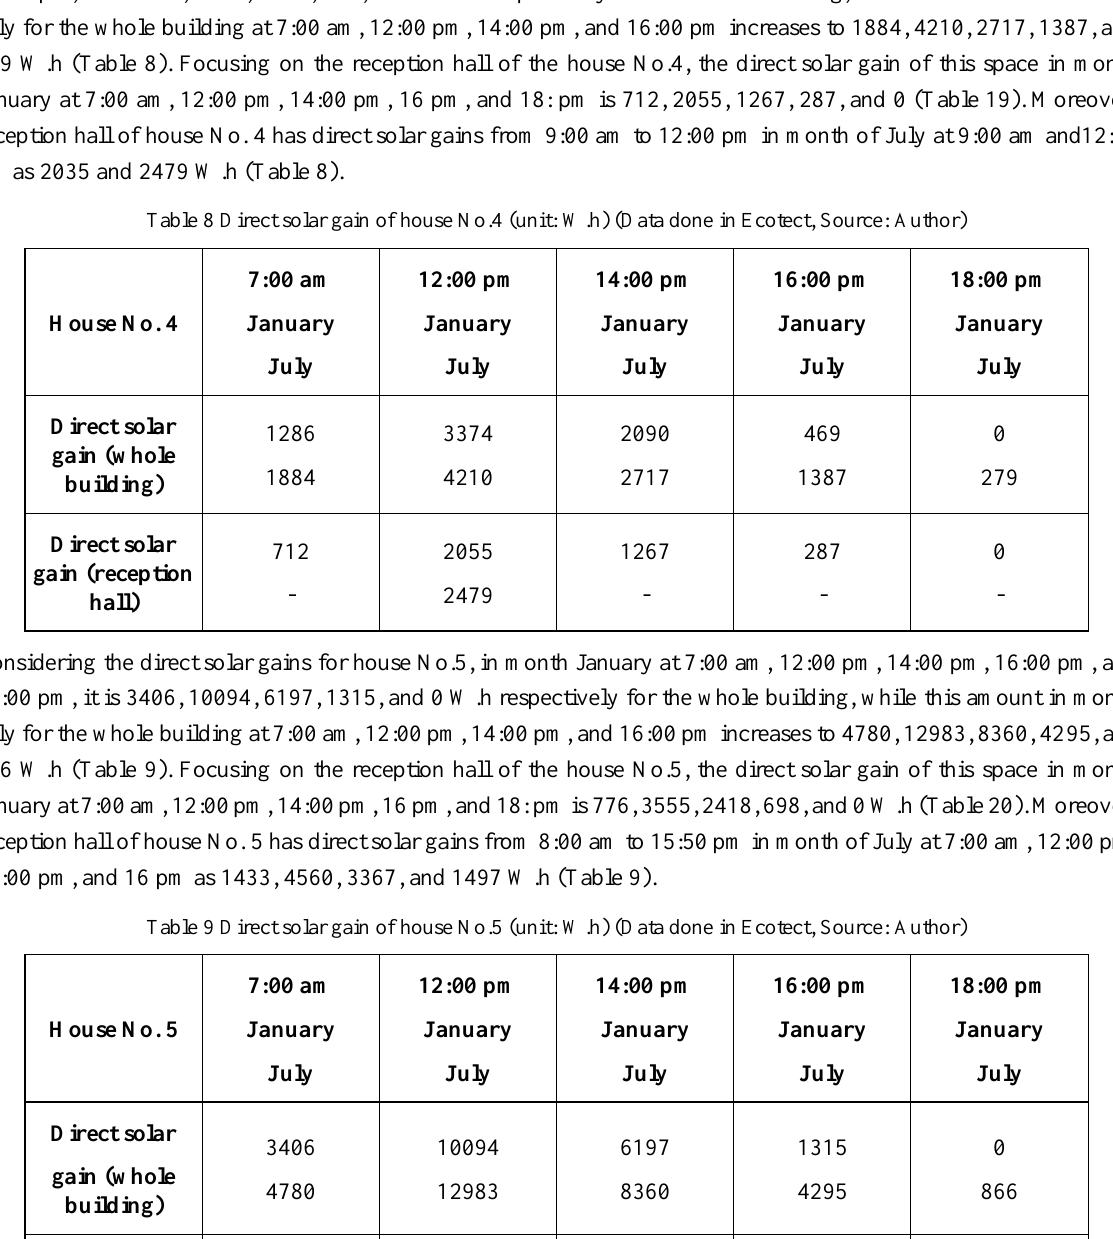
Table 8 Direct solar gain of house No.4 (unit: W.h) (Data done in Ecotect, Source: Author)